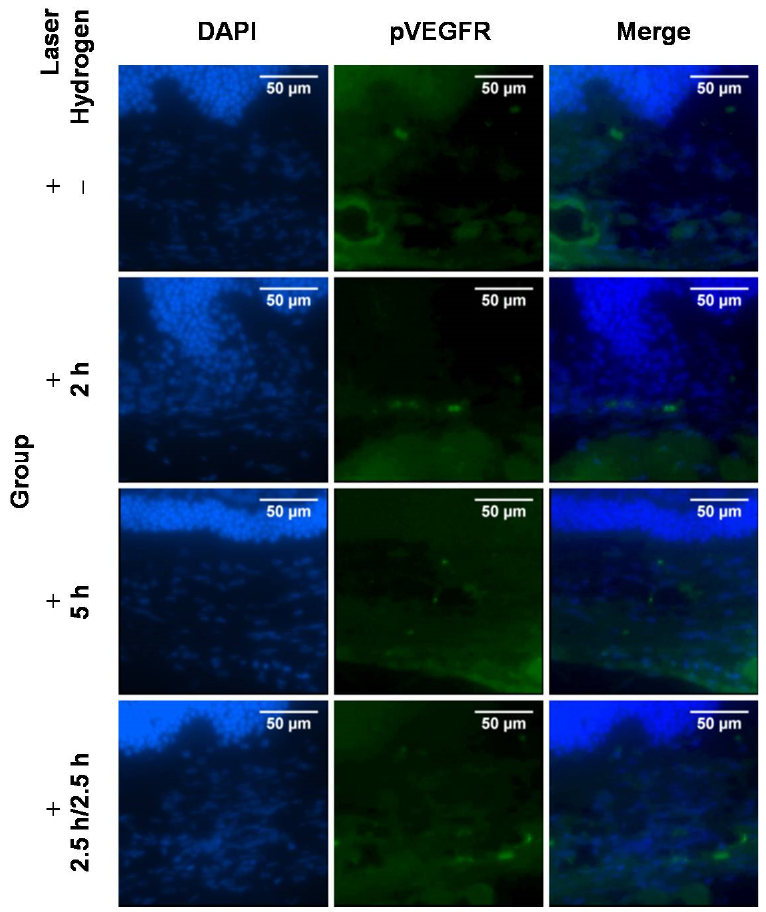
Figure 4. Immunofluorescence staining and the expression of pVEGFR on Day 15 (10 days after laser photocoagulation). 2.3. Hydrogen Gas Inhalation Downregulates the mRNA Expression of Hypoxia-Inducible Factor 1 alpha (HIF-1 α ) and Its Immediate Downstream Target VEGF in Laser-Induced CNV (n = 3)